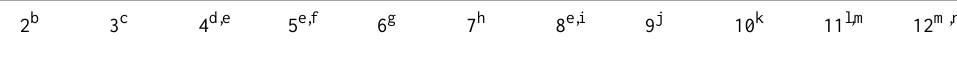
Table 3. Inter-item correlation matrix